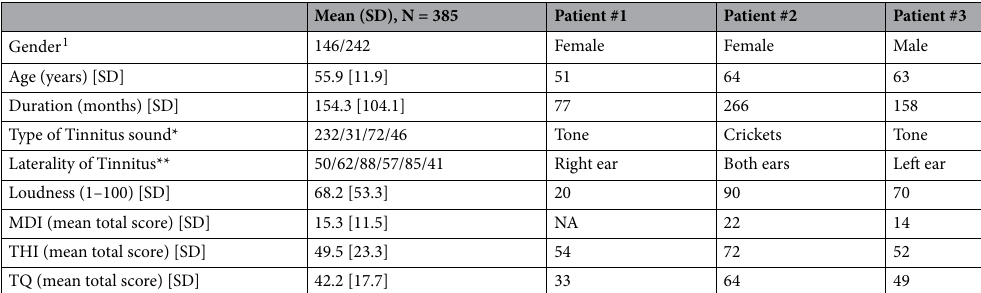
Table 1. Characteristics of our sample at T1. The characteristics of all three patients who reported losing their tinnitus between the two assessments is presented. 1: female/male ratio. * from left to right: Tonal, Noise, Crickets, Other. ** from left to right: right ear, left ear, both ears (worse in right), both ears (worse in left), both ears (equally bad), inside the head. NA: Non